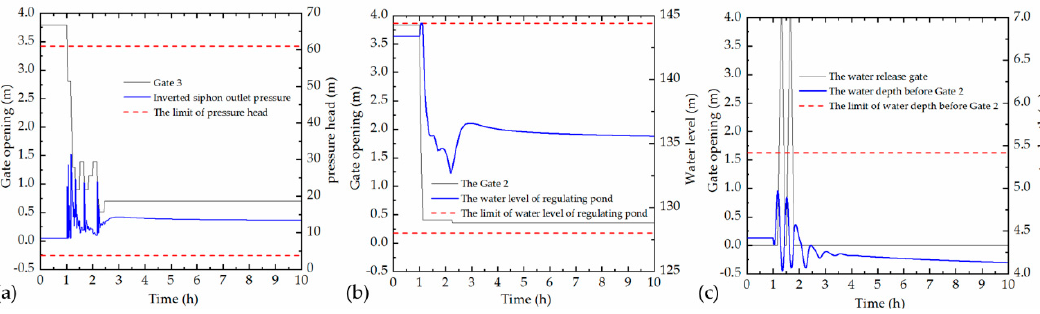
Figure 8. The simulation result of Scenario C with target flow of 10 m 3 / s: ( a – c ) are same with Figure 6.